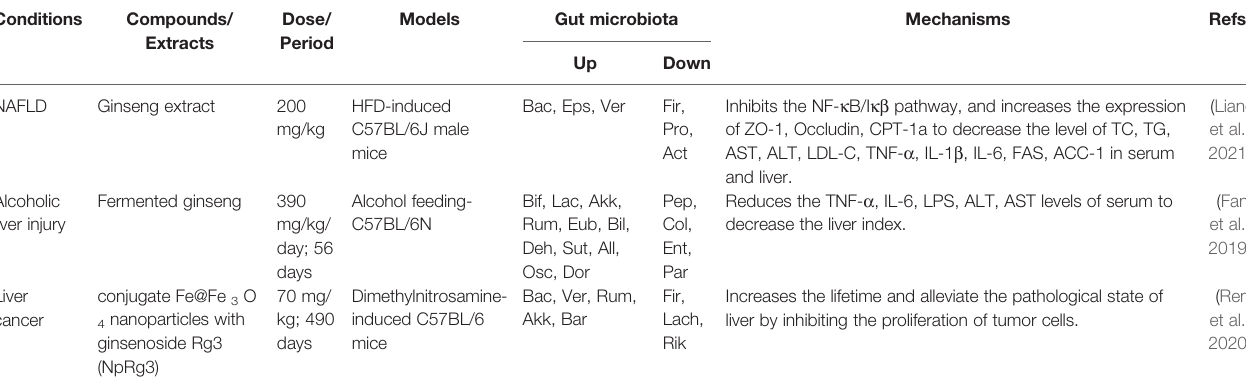
TABLE 3 | Summary of anti-liver diseases activities of ginseng by regulating gut microbiota and related pathways.